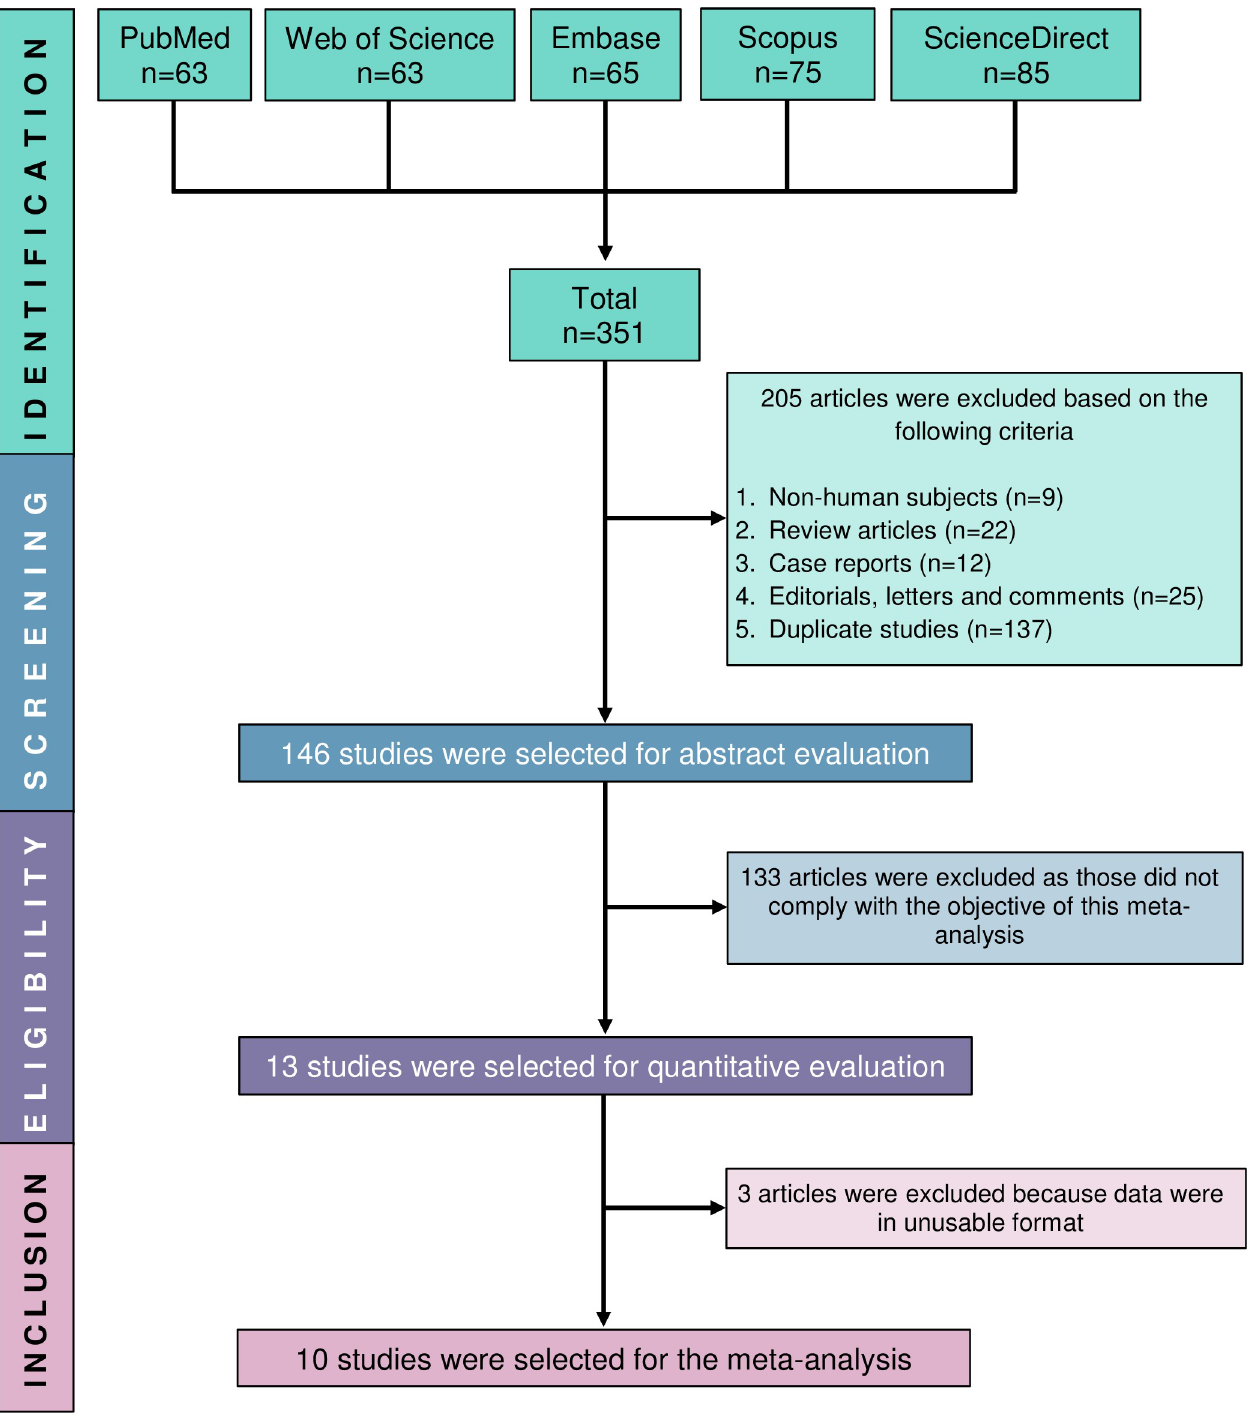
Fig 1. PRISMA flow diagram of study